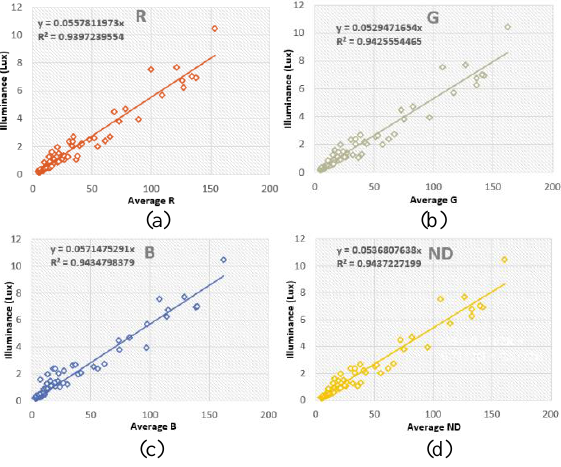
Figure 6. Scatter plot and trend line of (a) average red DN vs illuminance (b) average green DN vs. illuminance (c) average blue DN vs. illuminance (d) average ND vs. illuminance.